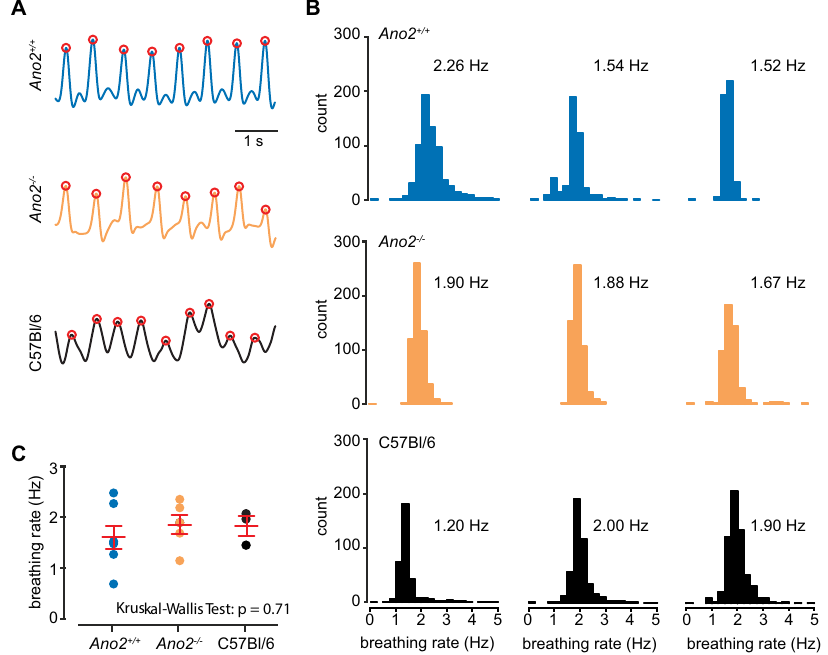
Figure 3. Loss of Ano2 does not impact respiration rate. ( A) Example respiration traces from a Ano2 + / + , Ano2 − / − and C57BL/6 J animals recorded with a thermocouple placed near the animal’s nose (see Supplemental Fig. 2 for technique validation). ( B) Histograms of the instantaneous respiration frequency in a 5-minute window from three representative animals from each group. Mean instantaneous frequency is displayed next to each plot. ( C) Mean instantaneous frequency for all animals in each group. Red bars denote mean and standard error across all animals (p = 0.71, Kruskal-Wallis